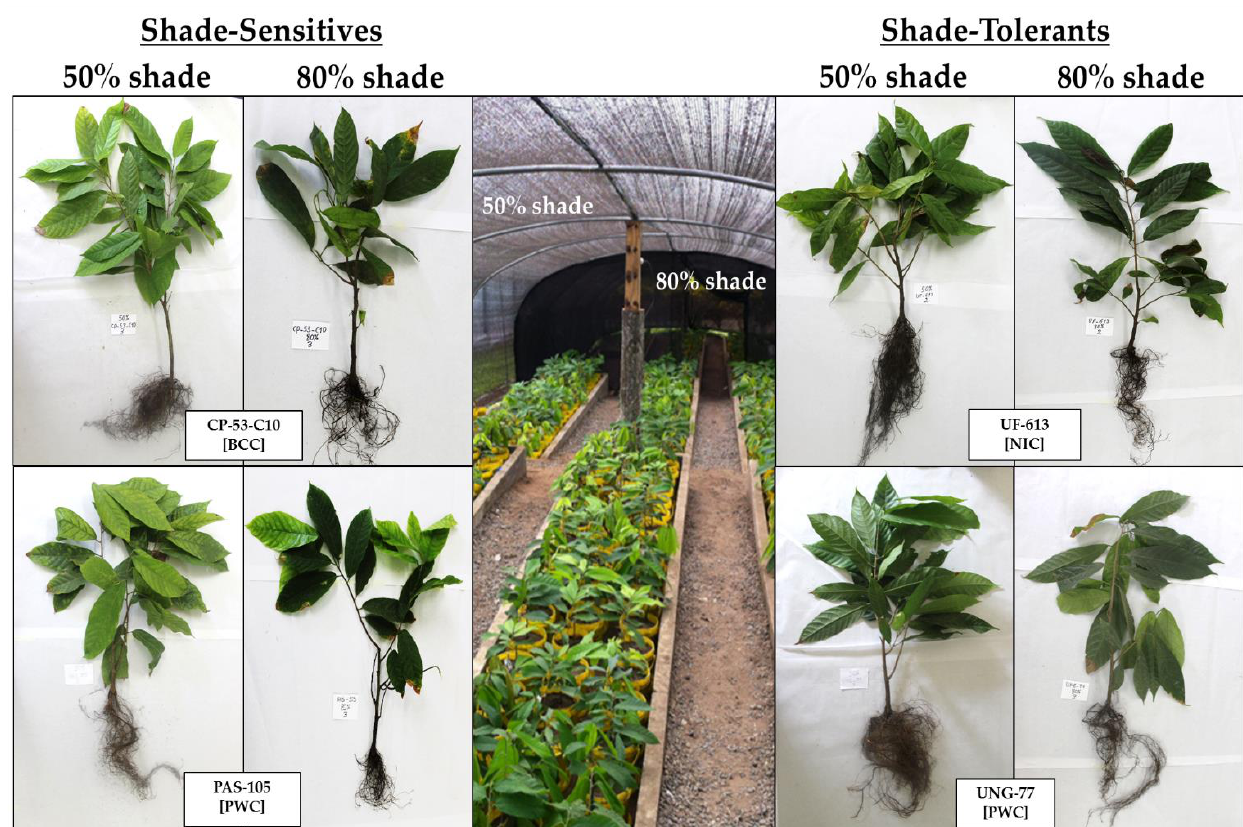
Figure 5. Seedlings captions of growth characteristics of cacao genotypes—both sensitive and tolerant to shade. The center figure shows the greenhouse with the plant distribution, note the net that provides 50% shade (grey color) and at the end net that provides 80% shade (black color).